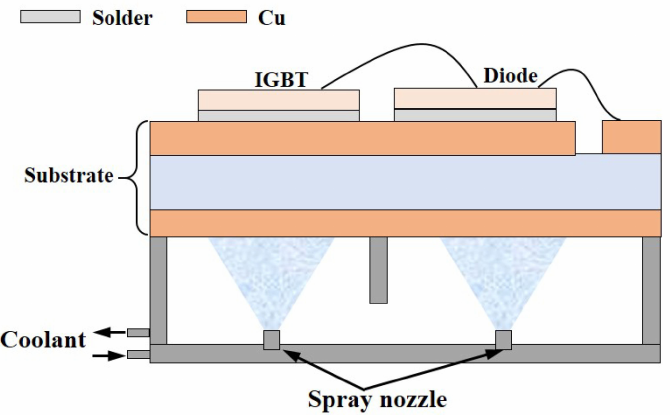
Figure 11. Schematic of a typical spray-cooled inverter module